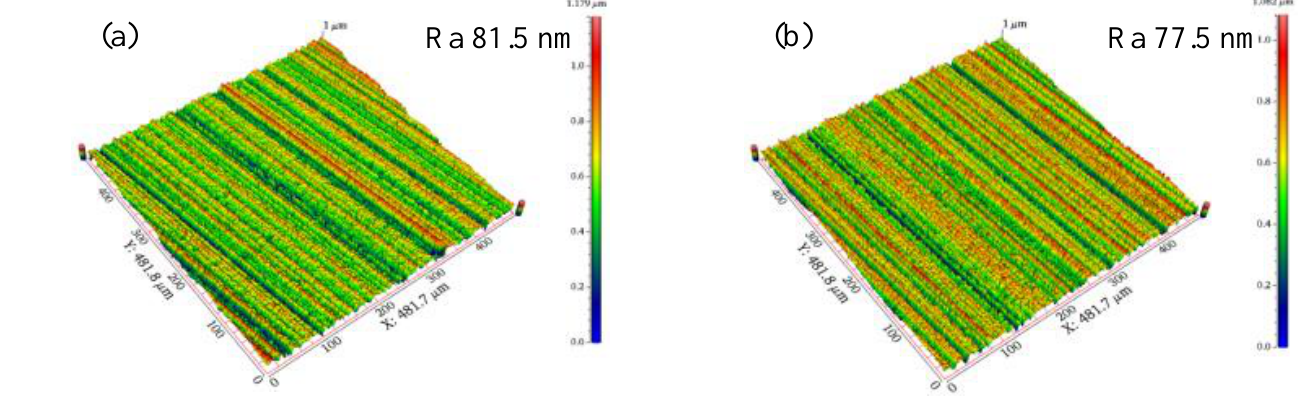
Figure 7. Experimental results under different polishing angles. It can be seen that the cutting edge preparation efficiency is the highest when the polishing angle is 10°, and the cutting edge radius increases from 17 μm to 110 μm after 5 mins’ polishing. While the cutting edge preparation efficiency is the lowest when the pol- ishing angle is − 20° and the cutting edge radius increased from 15 μm to 37 μm only. From